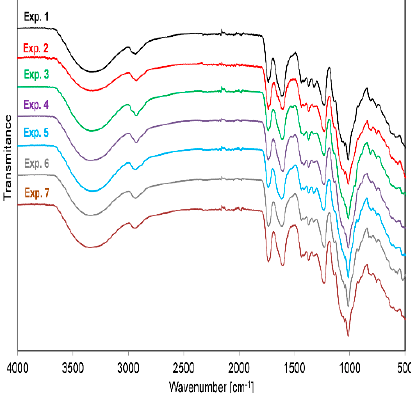
Figure 2. FTIR spectra of pectin samples in Experiments 1–7.